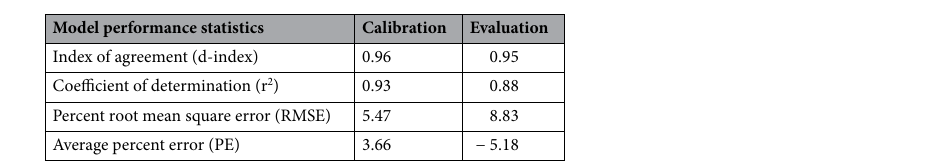
Table 2. Model performance statistics for seed cotton yield